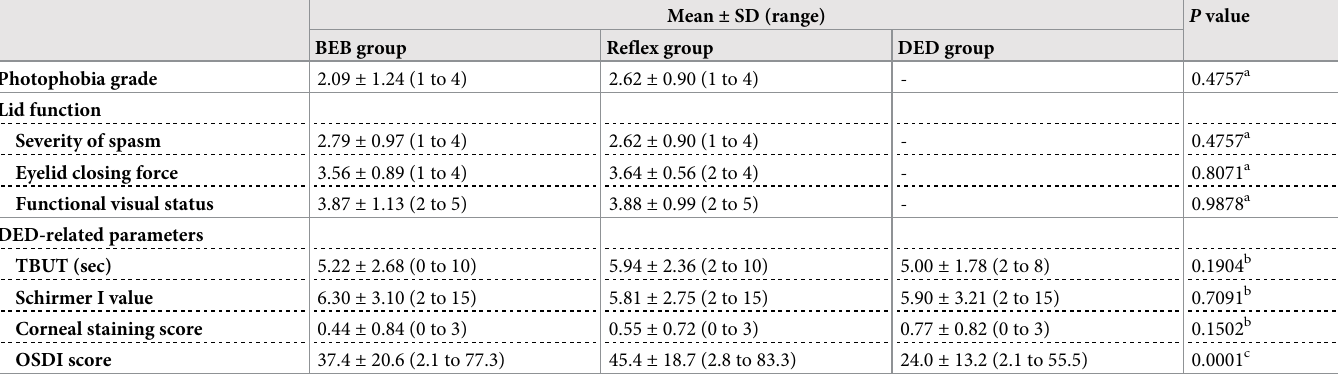
Table 2. The lid function, dry eye disease-related parameters, and photophobia grade in patients with benign essential blepharospasm and reflex